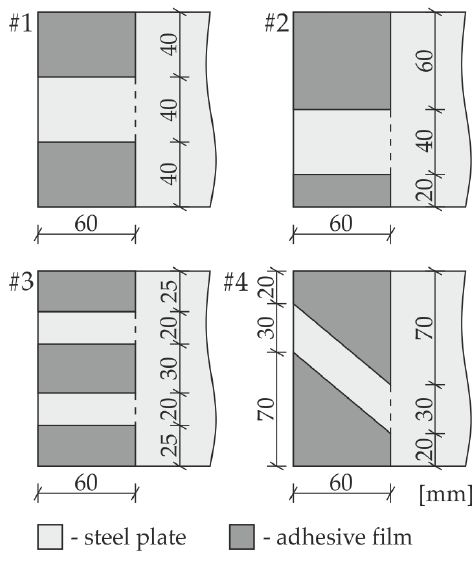
Figure 2. Variants of defects (#1 to #4).